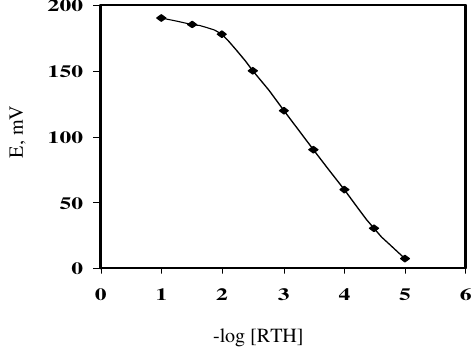
Figure 2. Typical calibration graph of RTH- selective electrode.